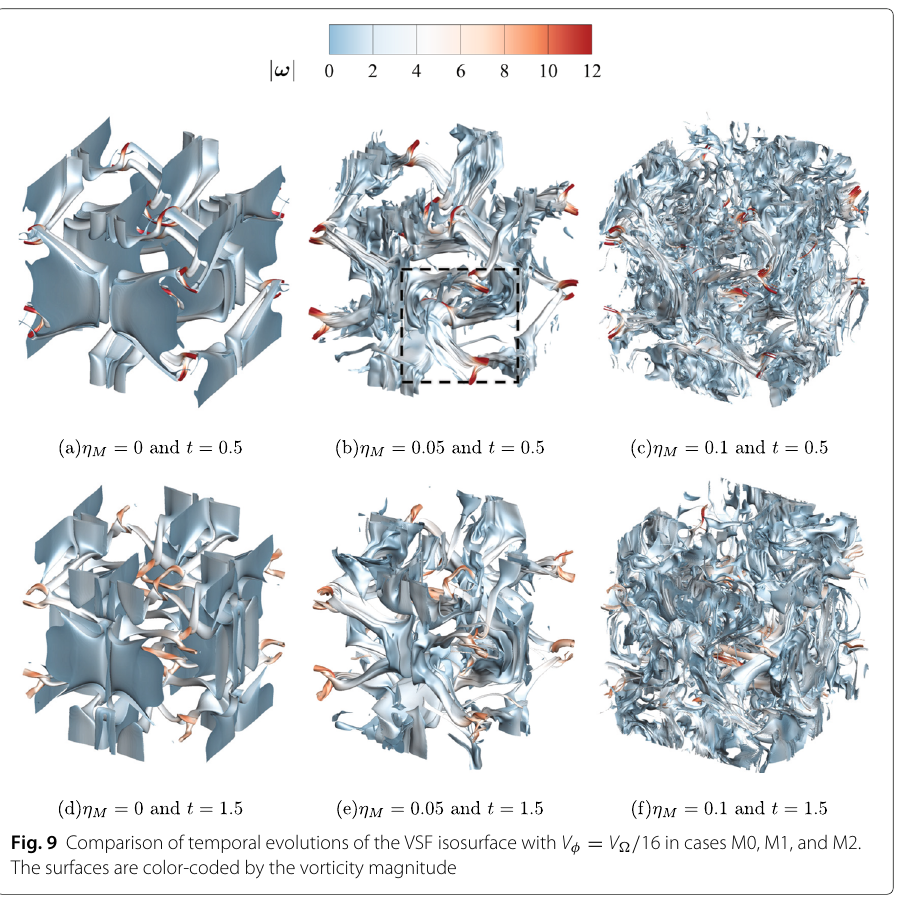
Fig. 9 Comparison of temporal evolutions of the VSF isosurface with V φ = V (cid:5) / 16 in cases M0, M1, and M2. The surfaces are color-coded by the vorticity magnitude